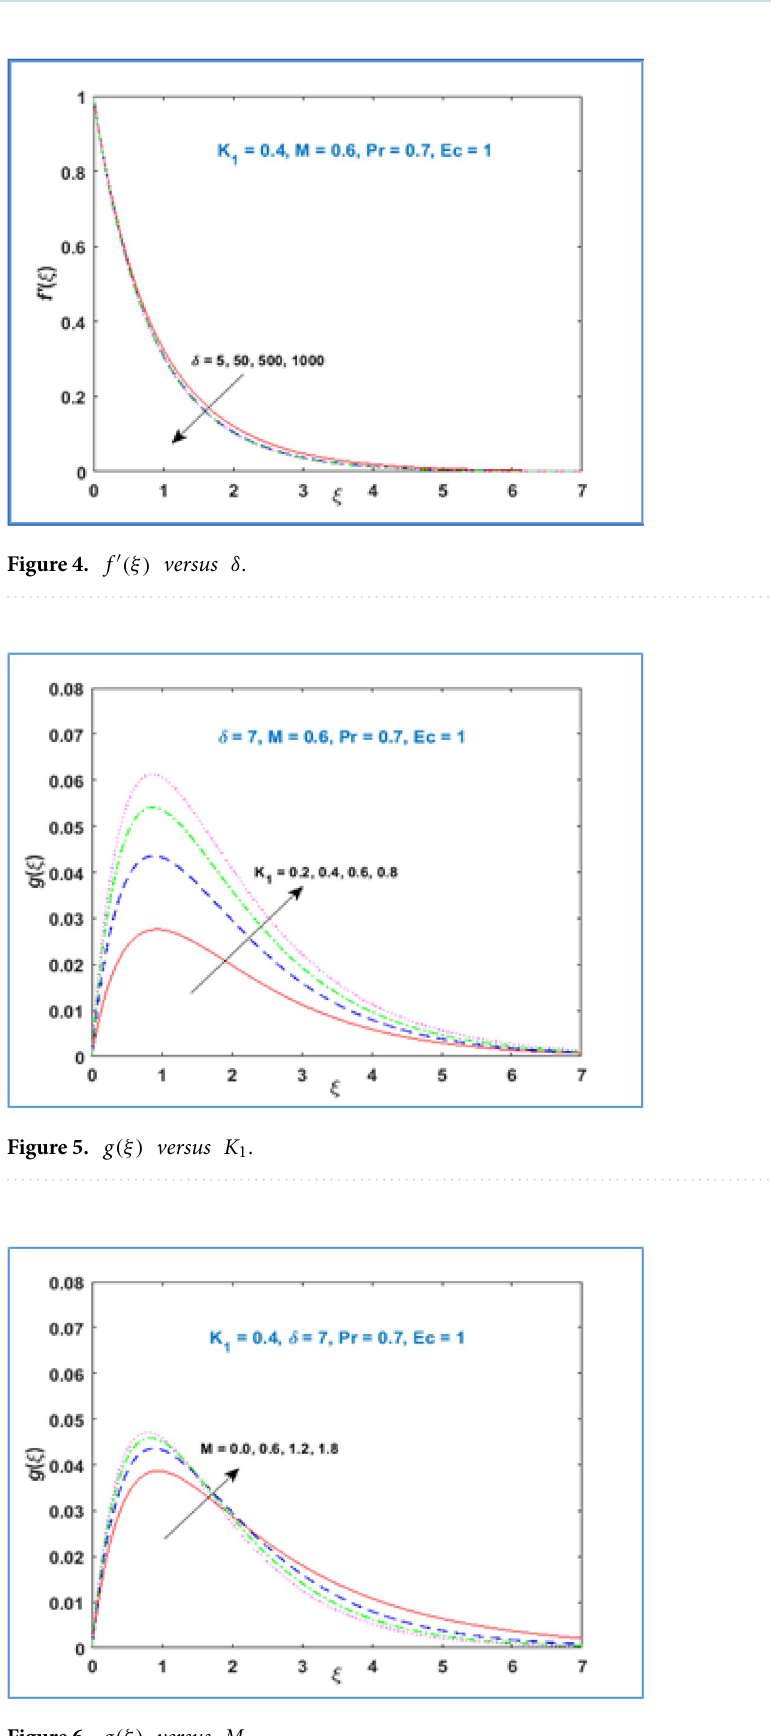
Figure 6. g (ξ) versus M